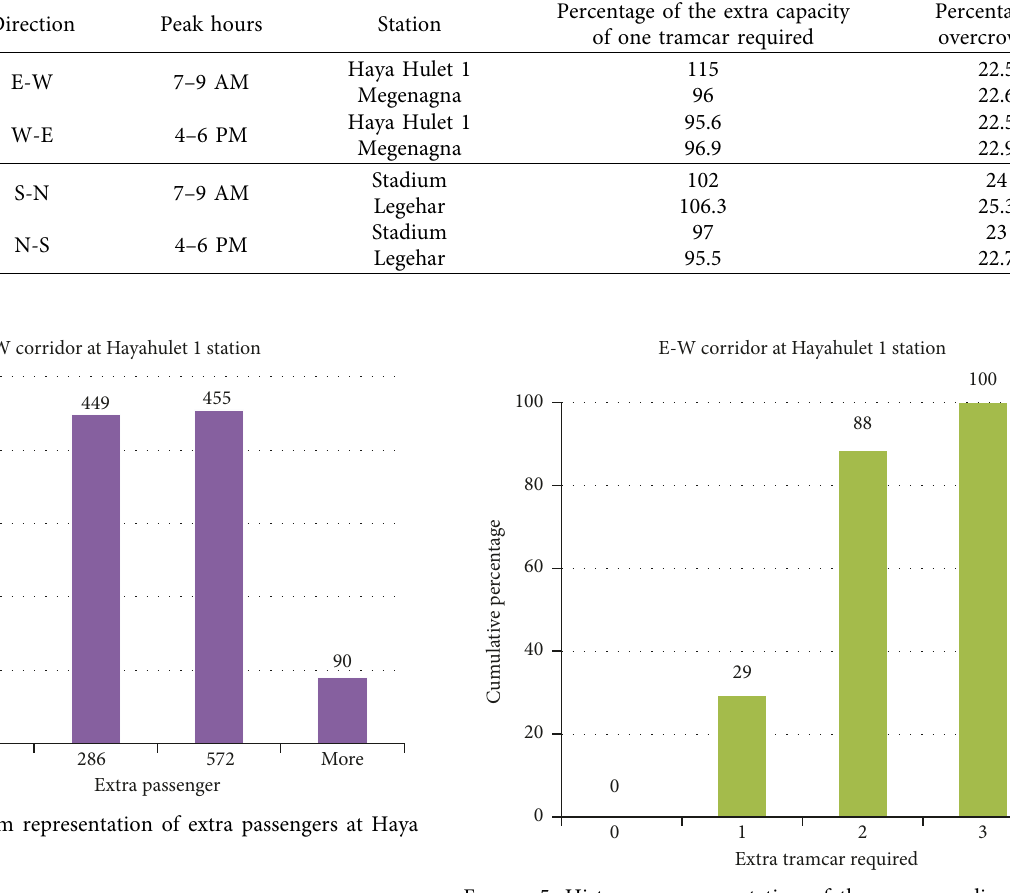
Table 2: The percentage of overcrowded and extra trains required at selected stations.